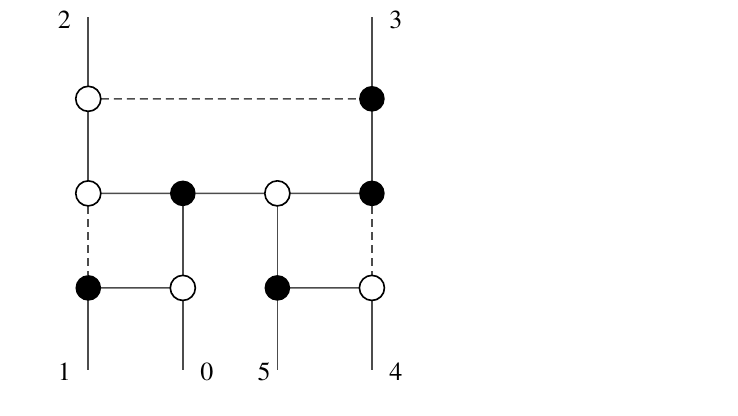
Figure 20 . On-shell diagram from which (cid:12)gure 19 can be obtained by taking a forward limit and adding a decorated BCFW